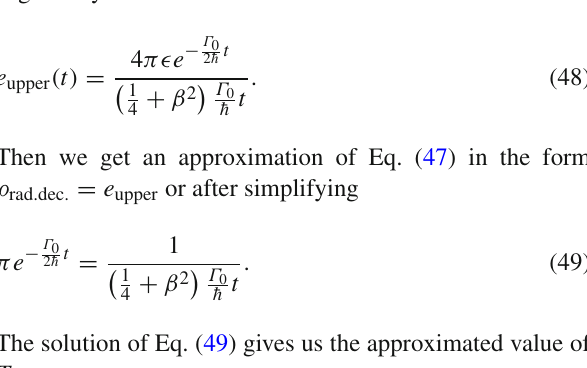
. In these 100 km